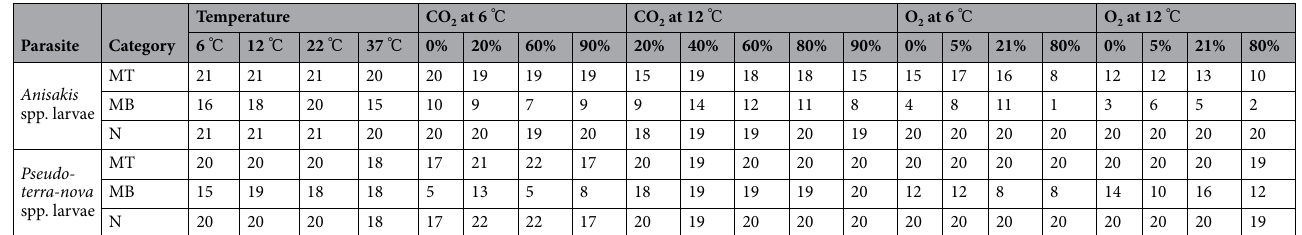
Table 1. Number of larvae that were motile/mobile in 30 min of CO 2 and O 2 experiments. MT the number of larvae that were motile in 30 min, MB the number of larvae that were mobile in 30 min, N total number of larvae analyzed (excluding ineligible